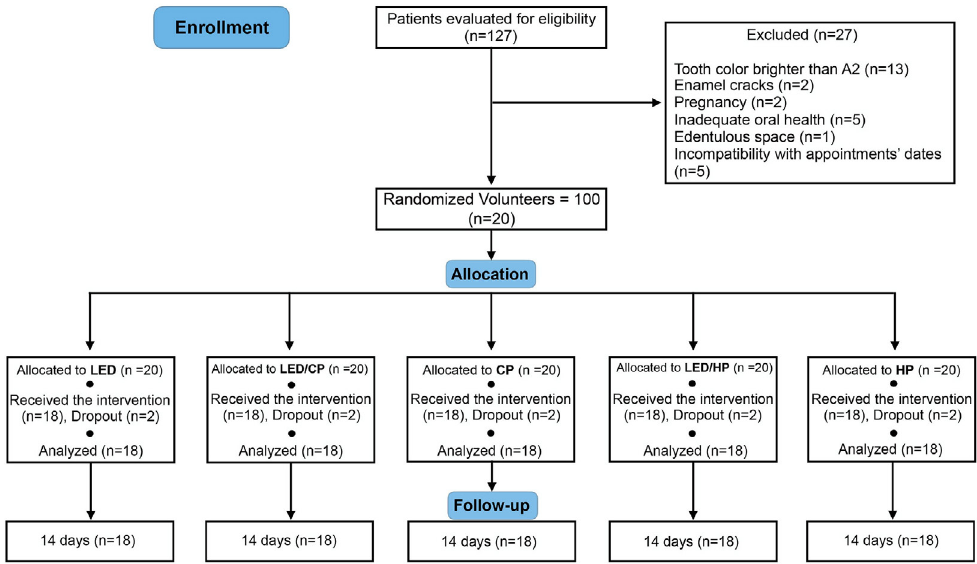
Figure 2- Flowchart of the RCT from the evaluation for eligibility of the volunteers to the Table 1- Baseline values for the CIEL*a*b* coordinates and main descriptive characteristics of the selected